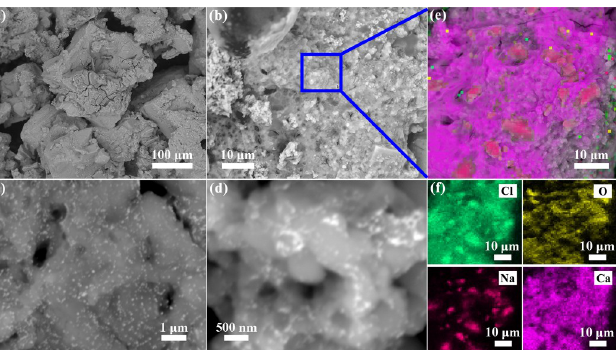
Fig 1. FE-SEM images of the original fracturing fluid at (a, b) low and (c, d) high magnifications. EDX Mapping results of the original fracturing fluid: (e) Mapping of all elements, (f) Mapping of Cl, O, Na and Ca.